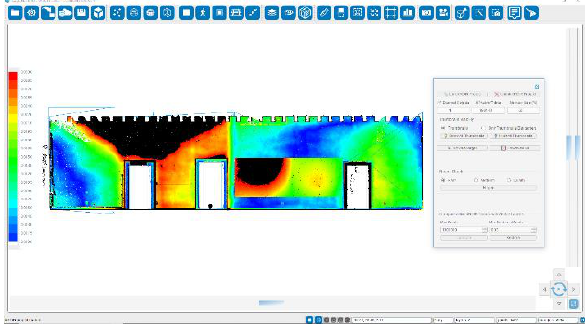
Figure 10. Internal wall: HBIM vs TLS points cloud.